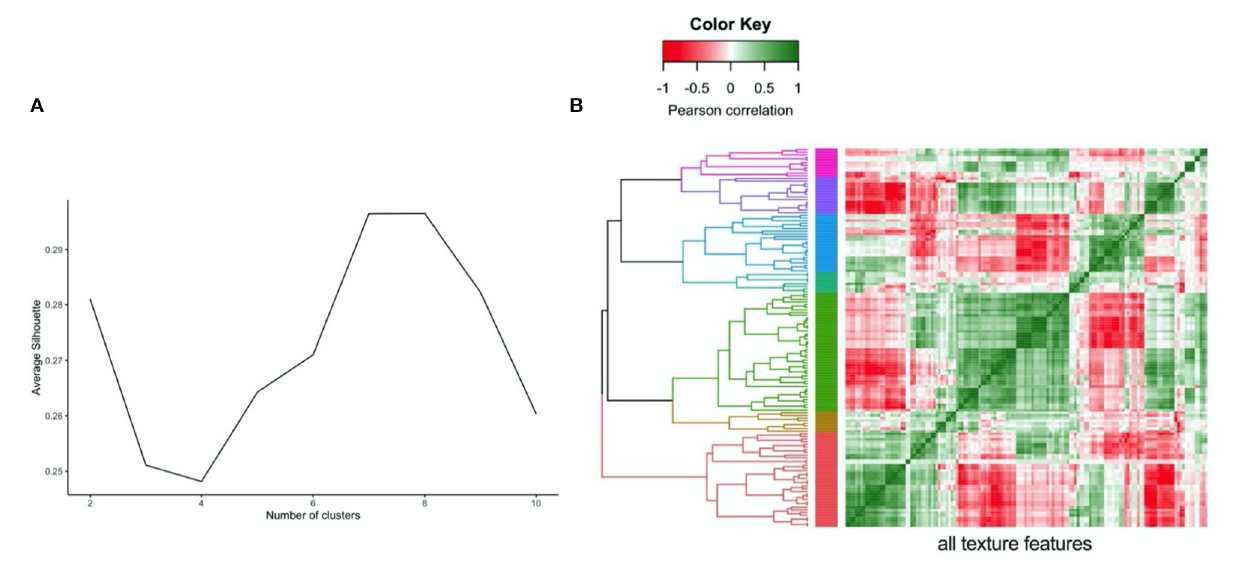
FIGURE 1 | Illustration of clustering method (hierarchical) and approach to defining the number of clusters (average silhouette approach) for the LV myocardium radiomics texture features. (A) Average silhouette statistic for complete-linkage hierarchical clustering of texture feature correlations. The silhouette statistic reflects the average distance between data points in the same cluster compared against average data points in other clusters and allows judgement of the optimal number of clusters within a sample, such that distance between datapoints within clusters are minimised whilst maximising distance with datapoints from other clusters. We computed average silhouette statistic for 2 to 10 clusters. Maximum silhouette statistic was observed with 7 and 8 clusters. Hence, we take 7 clusters as representing the optimal number of clusters within our samples. (B) Correlation heatmap, rows and columns correspond to all texture features creating grid with all possible pairs of texture features, grid colour corresponds to Pearson Correlation between pair of features at that point. Grid rows re-ordered by hierarchical clustering of correlations with tree coloured for optimal seven cluster cut of the tree.